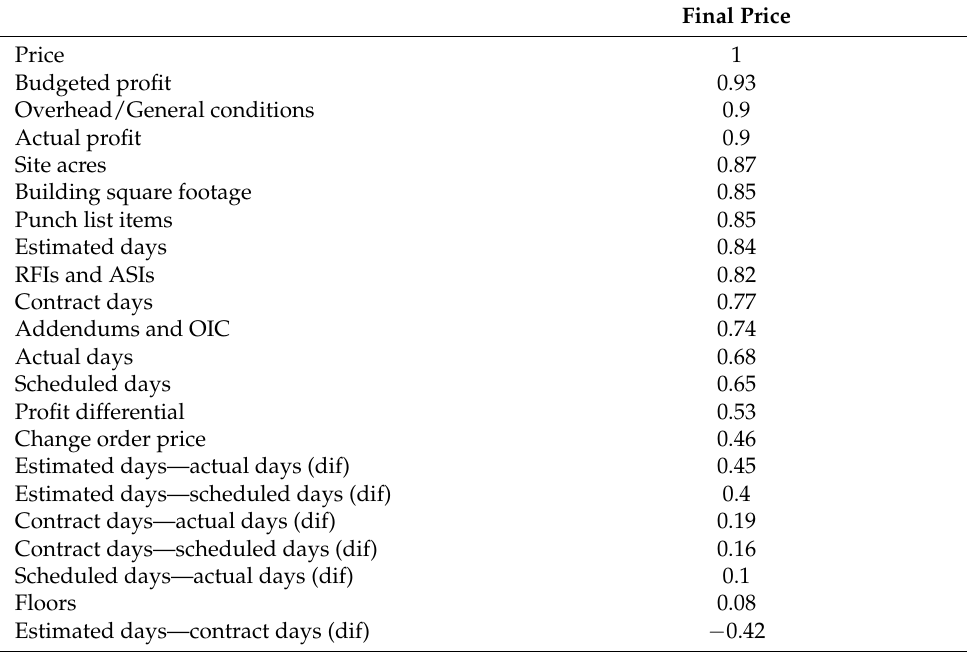
Table 5. Correlations for final